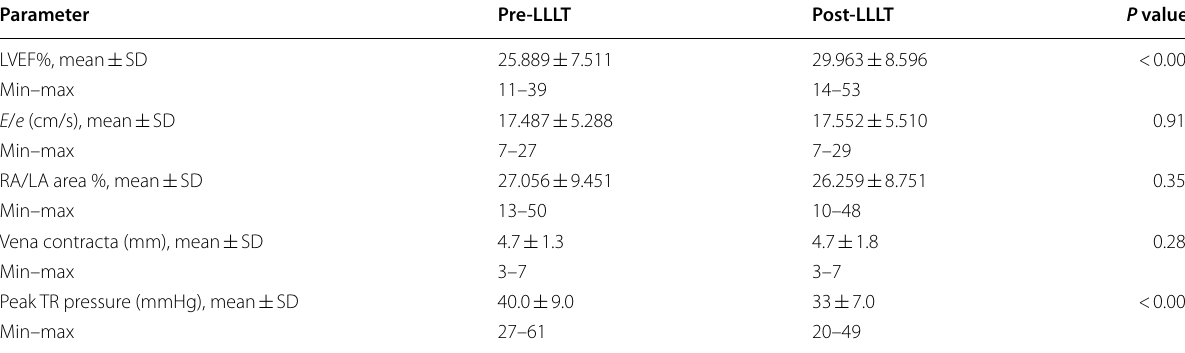
Table 3 Echocardiographic parameters assessment of the study